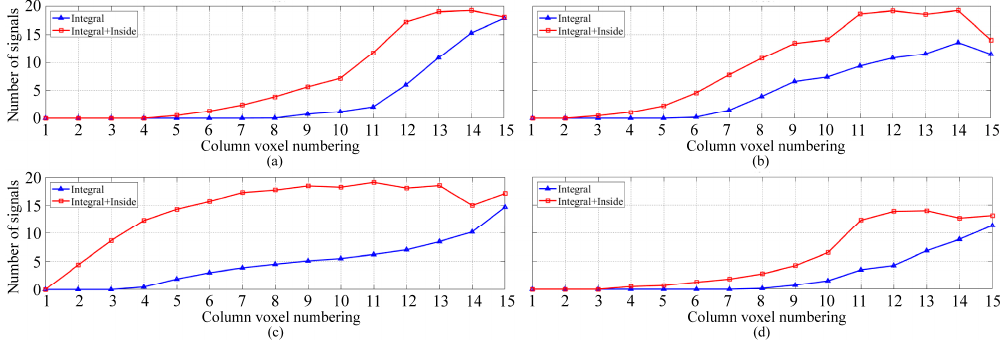
Figure 10. The number of penetrated signals in the RS-voxels column, where the abscissa represents the bottom-up column voxel numbering. ( a ) Scheme East; ( b ) Scheme West; ( c ) Scheme South; and ( d ) Scheme North.